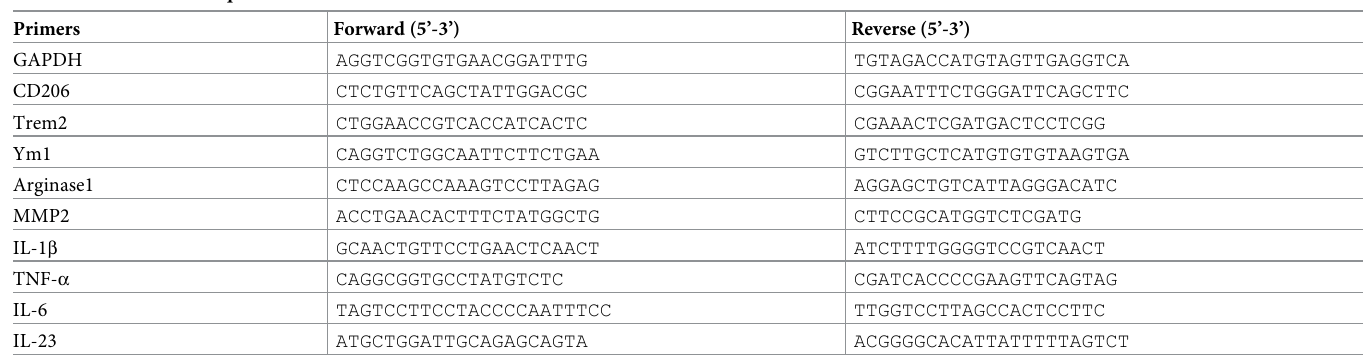
Table 1. Primers used in